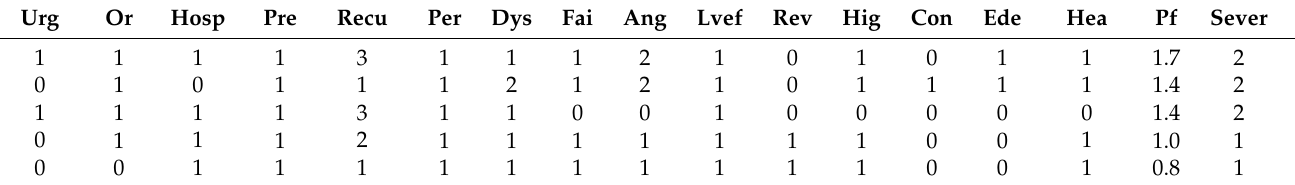
Table 3. Five random data rows showing the characterization of anonymous chronic